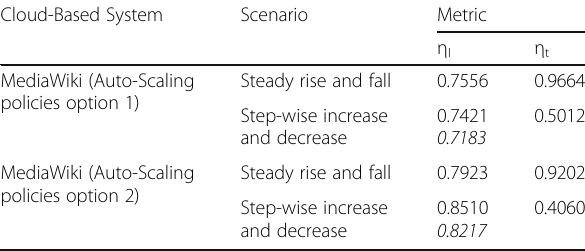
Table 7 Scalability metrics values Cloud-Based System